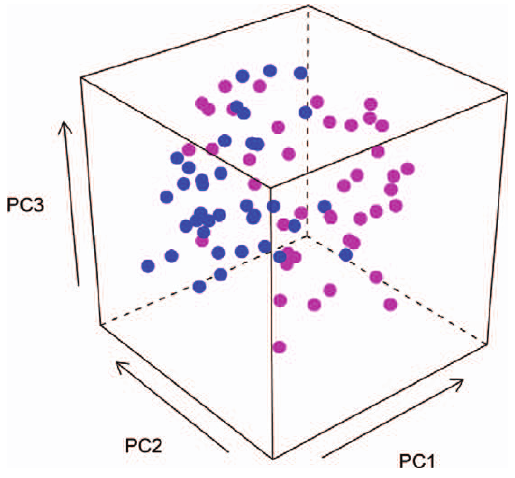
Figure 6. A PCA Plot The 79 samples of the ALL dataset are projected on the first three PCs derived from the 50 original features. The blue and magenta colors are used to denote the known membership of the samples in the two classes, NEG and BCR/ABL, respectively. Note that PCA is an unsupervised data projection method, since the class membership is not required to compute the